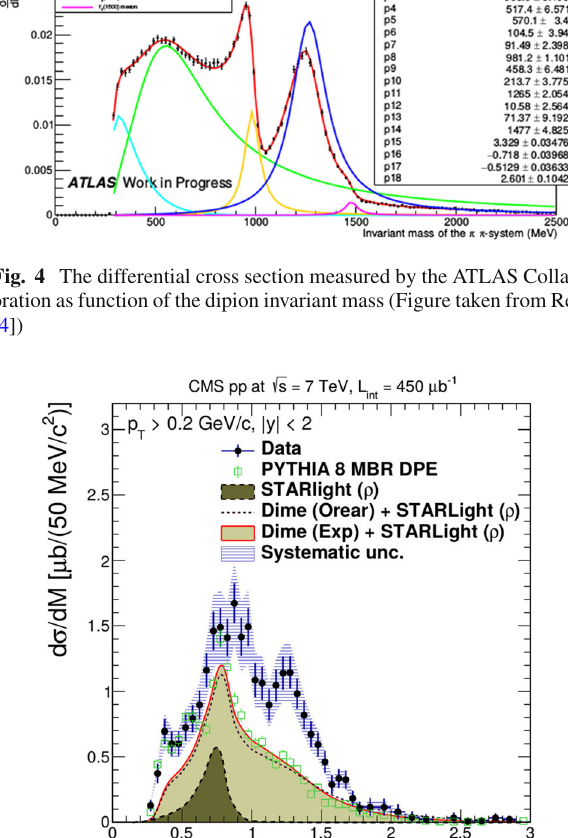
and the sum of all resonances, continua and interferences (in red).